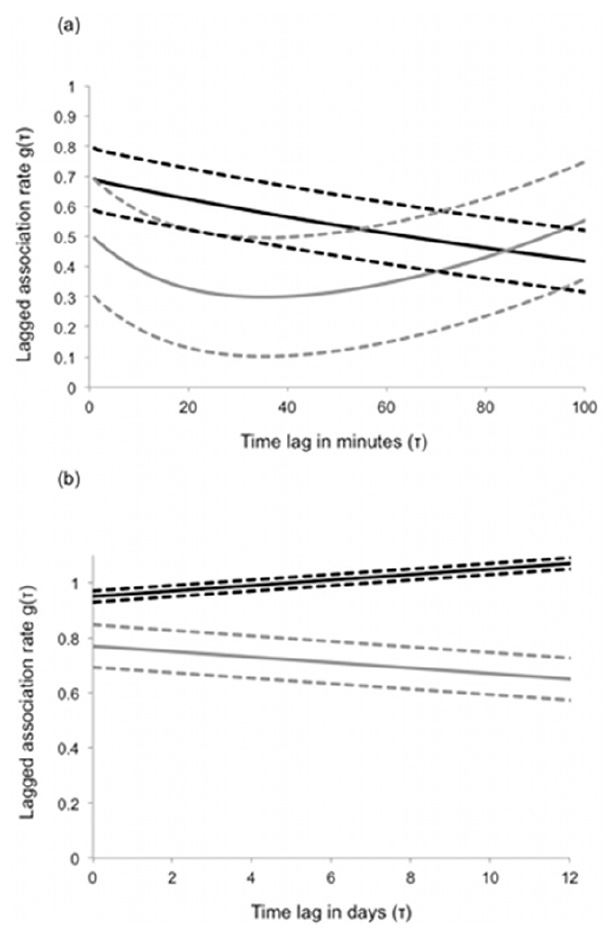
Figure 3. Models of temporal social structure in guppy populations. Lagged association rates are plotted against time lag in minutes (a) and days (b) for networks from high (black lines) and low (grey lines) predation populations. Solid lines indicate mean parameter values; dotted lines indicate the upper and lower boundaries for the standard error of the mean parameter values. The x-axis extends beyond the 30-minute sampling period (in fig. a) to illustrate the longer, 2nd period of fission predicted by the models.